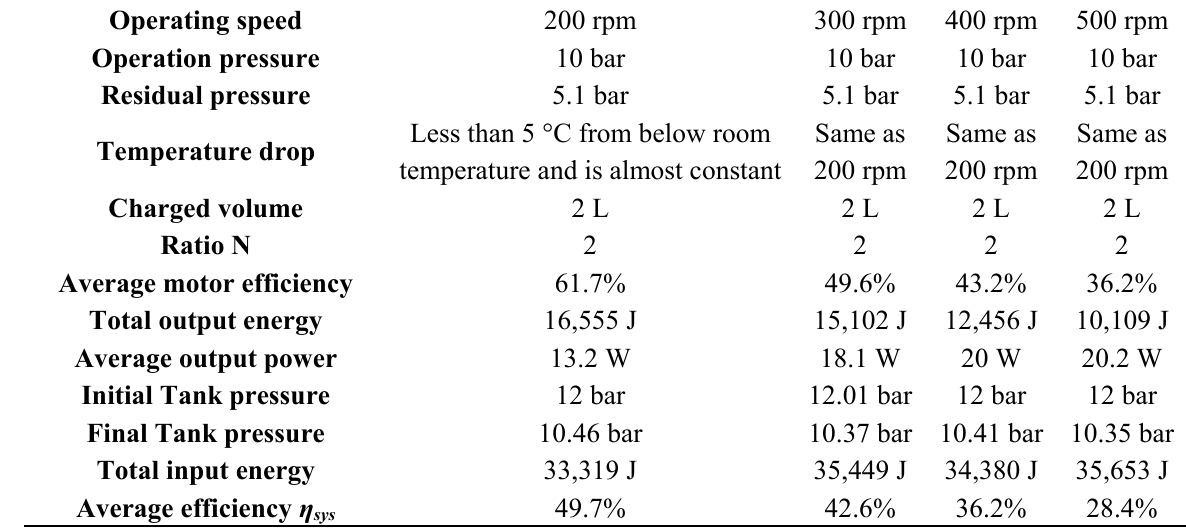
Table 1. The parameters and results of the expansion operation